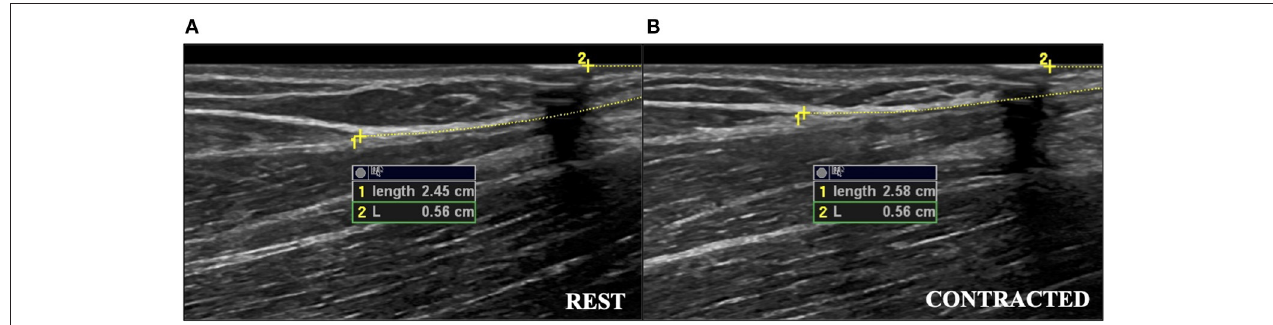
FIGURE 2 | The ultrasound measurements of tendon elongation in a young female during a 25% MVC contraction. (A) Measurement at rest of distance from muscle-tendon junction to edge of ultrasound field of view (Length 1), and measurement of distance from hyperechoic marker to the edge of ultrasound field of view (L2). (B) Measurement during the contracted state. The difference between the measurements during the contracted and resting states was used as the measure of tendon elongation. Images have been cropped for reproduction, but analysis captured the full length of the tendon. MVC, maximal voluntary